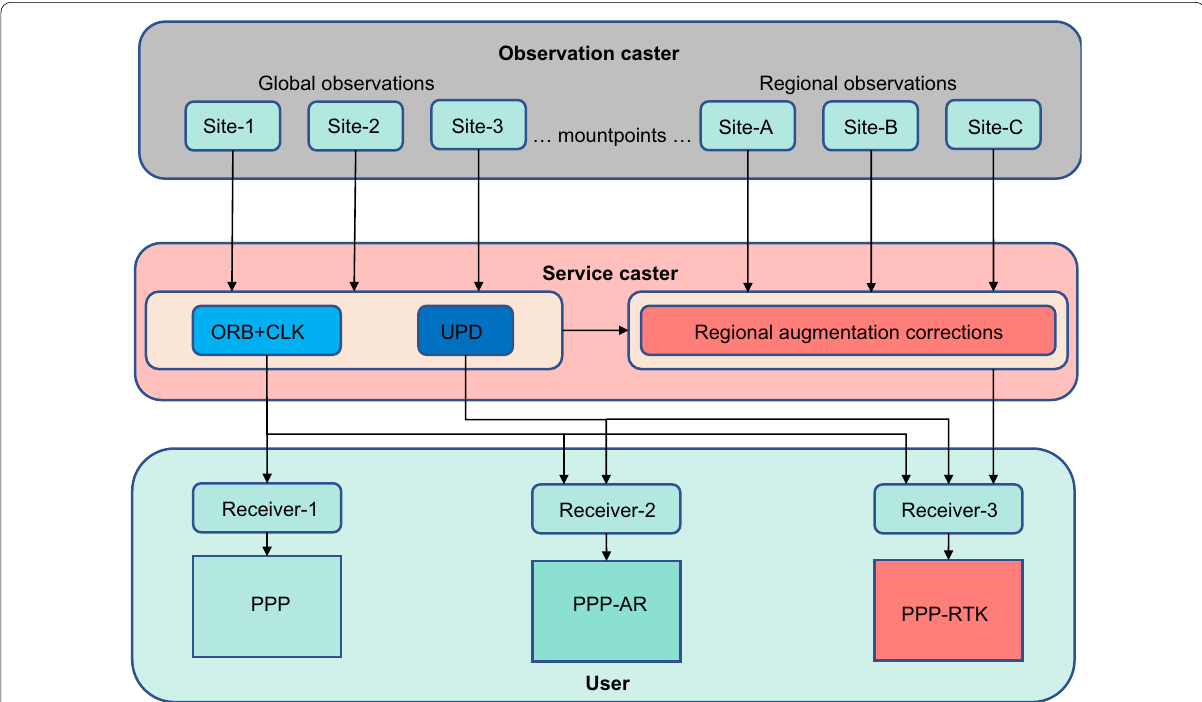
Fig. 2 General flow of a PPP-RTK system (ORB and CLK refer to precise satellite orbit and clock corrections,